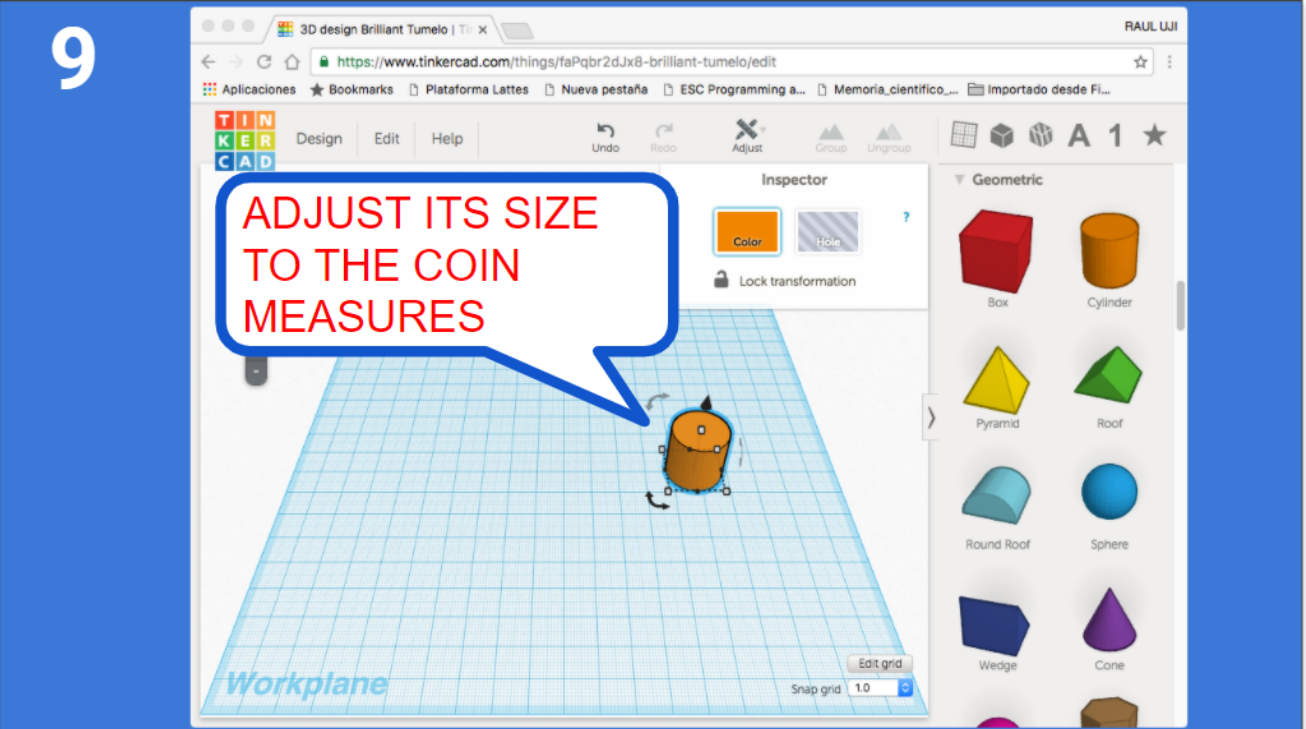
Figure 6. Example of tool designed by a high-school team during a stage at the Robotics Lab. The high-school students get a step-by-step guidance in order to get introduced to 3D design and printing. At the moment of writing this article, the tool that has been used for high-school teams is Tinkercad [27], which enables them to create accurate designs by using primitive shapes and operations via a single web interface (see Figure 7).